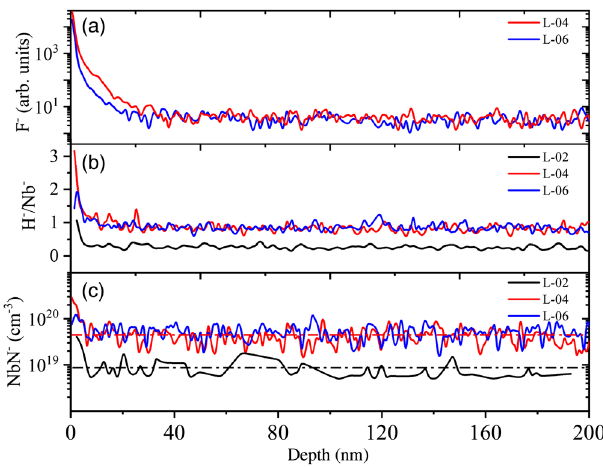
FIG. 8. TOF SIMS measurements for samples L-04 (BCP), L-06 (EP) and L-02 (nondoped); (a) concentration of F − in arbitrary unit (b) H − = Nb − and (b) concentration of NbN −